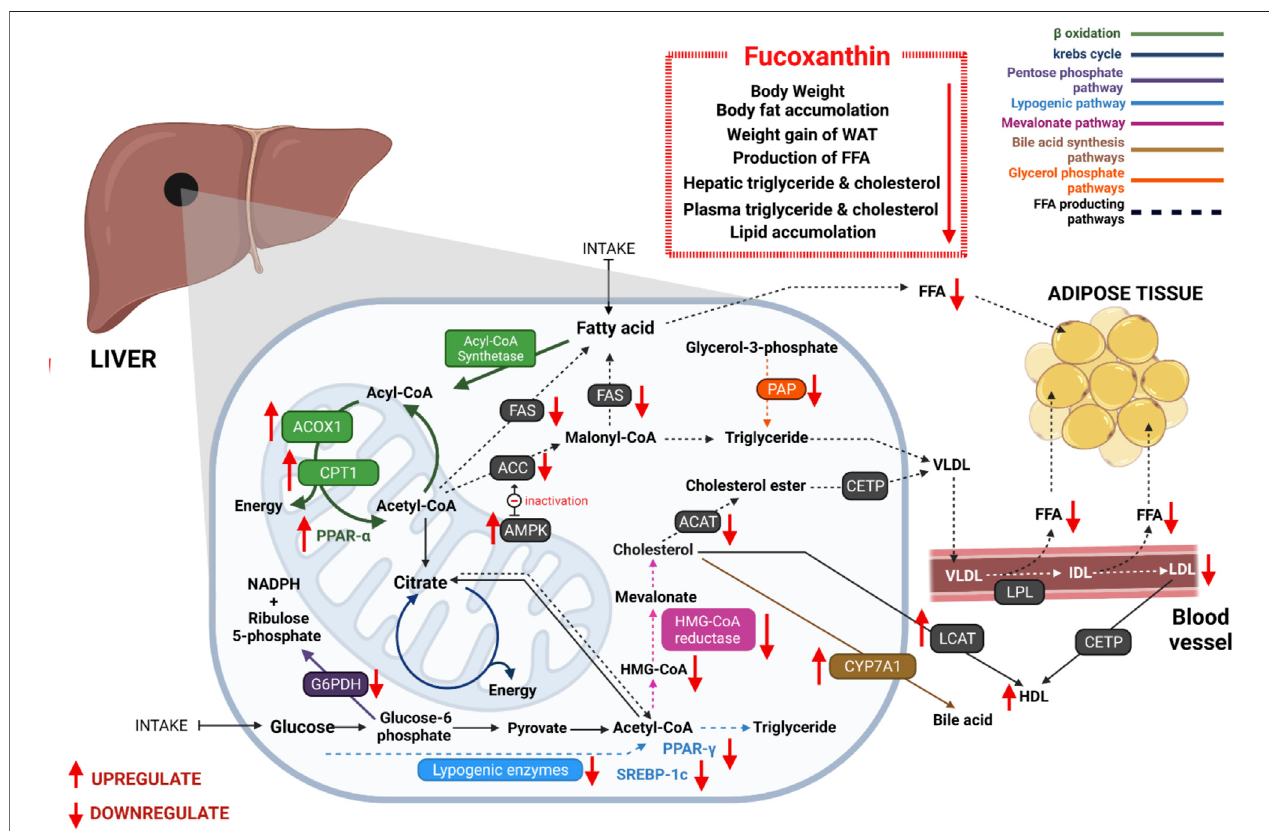
FIGURE 2 | Antiobesity effects of FX through regulating lipid metabolism: FX signi fi cantly reduces freefatty acid synthesis via controlling many enzymes, which are associatedwithlipidmetabolism.Itpromotes β -oxidation,bileacidsynthesispathway, andSirt1/AMPKpathway andinhibitslipogenesis, mevalonate pathway,pentose phosphate pathway, and glycerol phosphate pathway. As a result, plasmatic and hepatic triglyceride and cholesterol concentrations are decreased. It reduces lipid accumulation in hepatic cells and adipose tissues.